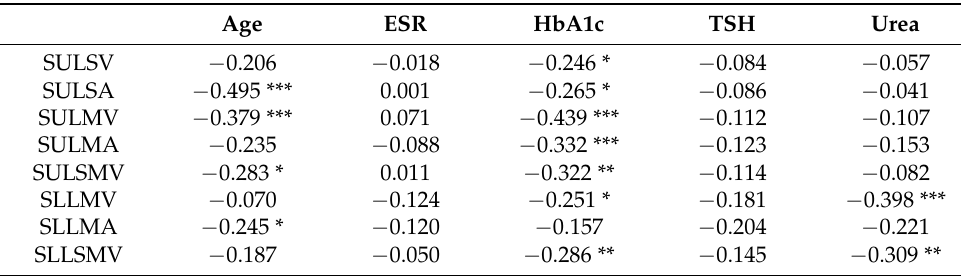
Table 5. Multiple regression models with nerve conduction parameters serving as the dependent variable—Standardized beta